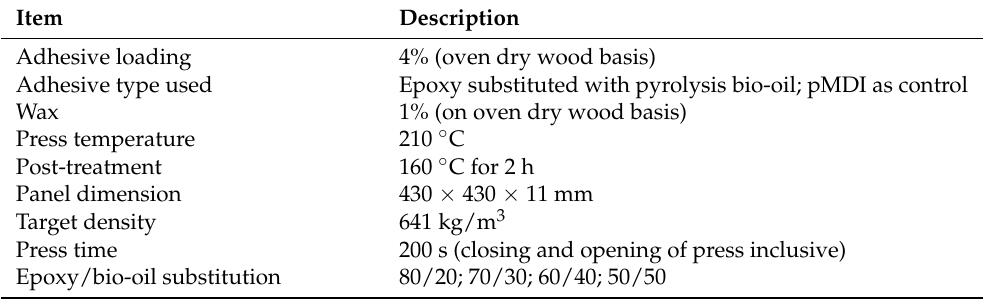
Table 1. OSB manufacturing